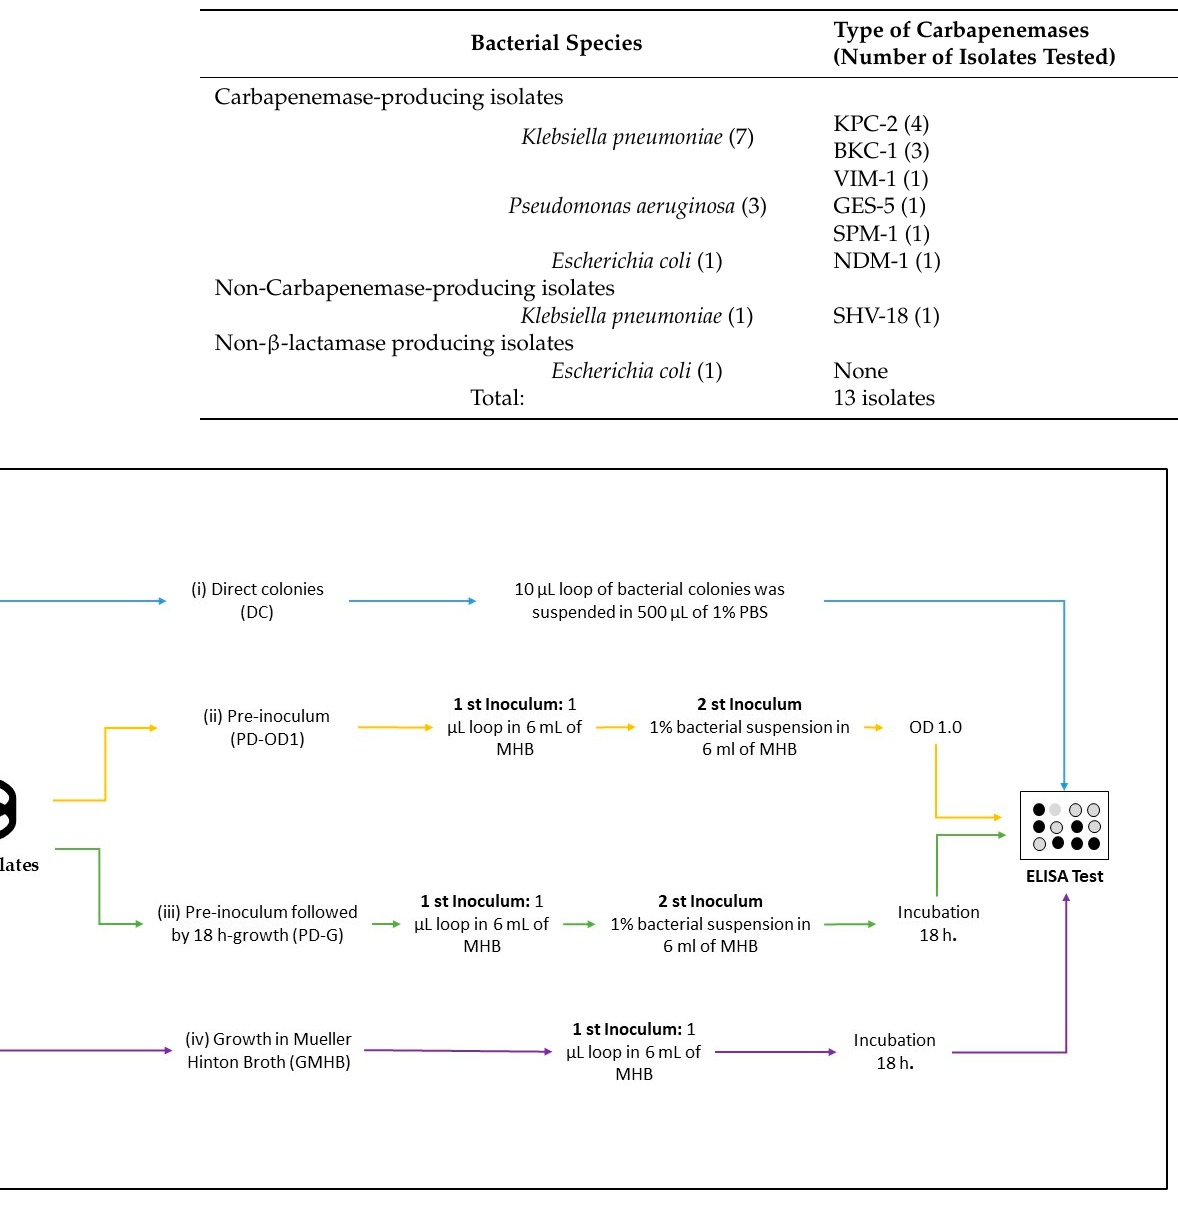
Figure 1. Graphical summary of protocols for the preparation of bacterial isolates before the ELISA test.